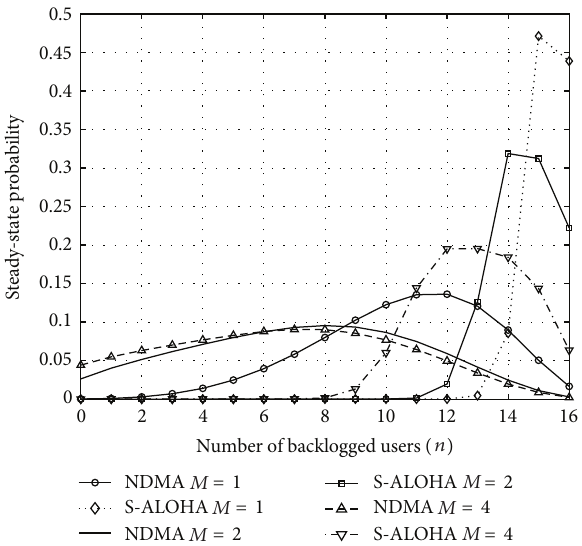
of backlogged 𝜋𝜋(𝜋𝜋)